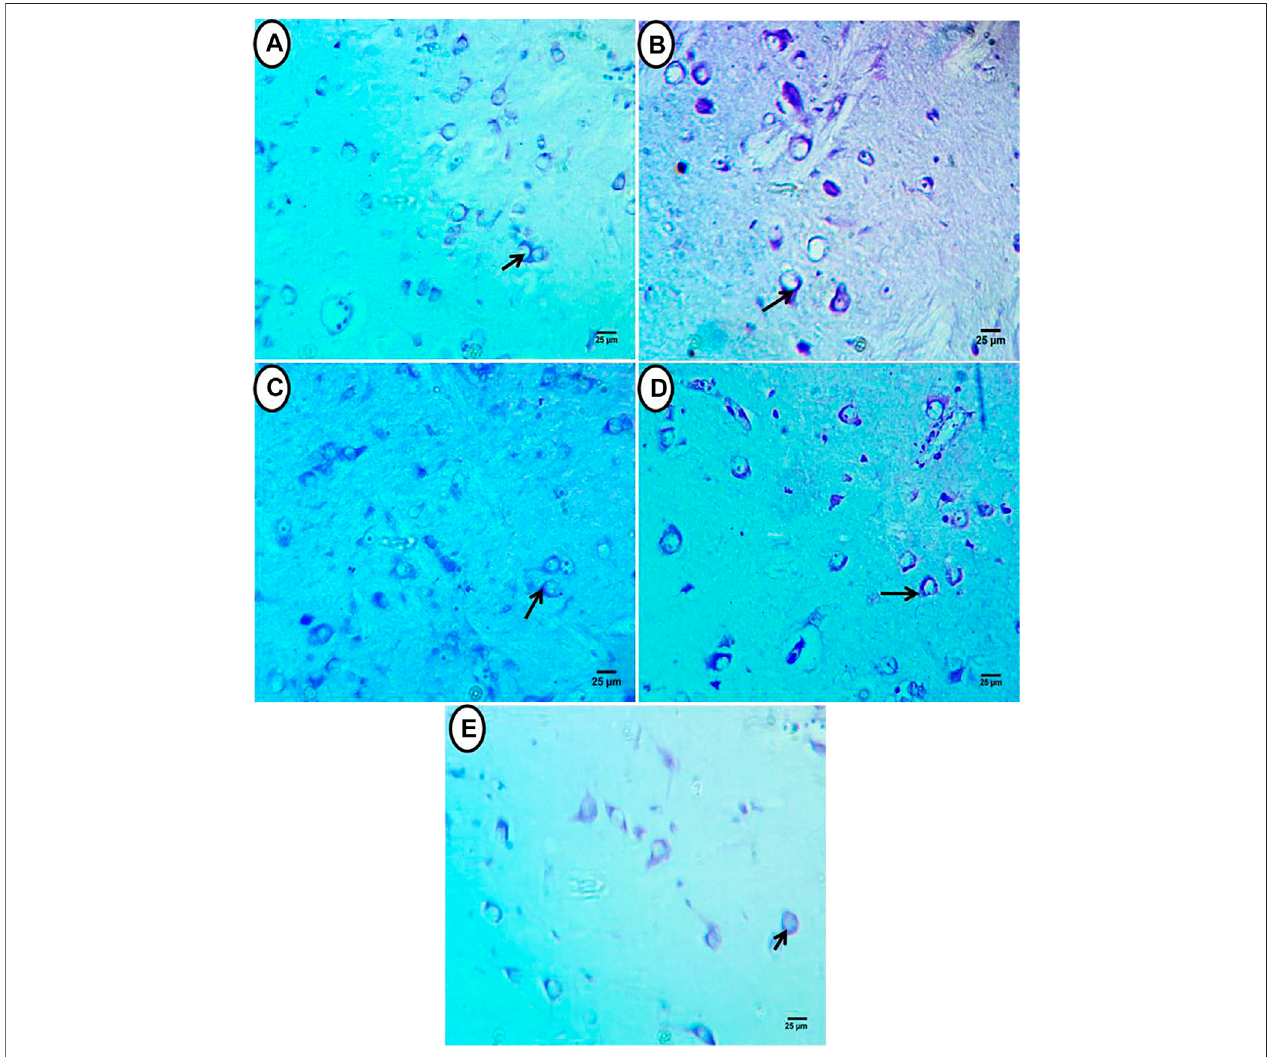
FIGURE 3 | Transverse sections of telencephalon of African cat fi sh ( C. gariepinus ) exposed to PE-MPs and PE-MPs with lycopene, citric acid and chlorella as antioxidants for 15 days. (A) Control group showed normal appearance of neurons and its contents of RNA (black arrow). (B) (PE-MPs 500 mg/kg diet) exposed group showed increase in RNA contents which distributed in shrunken neurons and appeared deeply stained. (C) PE-MPs + lycopene (500 mg/kg diet), (D) PE-MPs + citric acid(30 g/kgdiet)and. (E) PE-MPs +chlorella(50 g/kgdiet)exposedgroups,showedincreaseinRNAcontentslocatedperinucleiintheneuronsandtheirneuritis with remarkable increase in PE-MPs + citric acid (30 g/kg diet) exposed group (D) , Cresyl violet, Scale bar 25 µm.